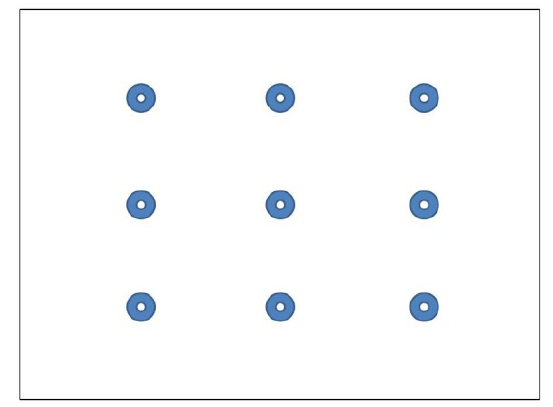
Figure 2. Example of the experimental